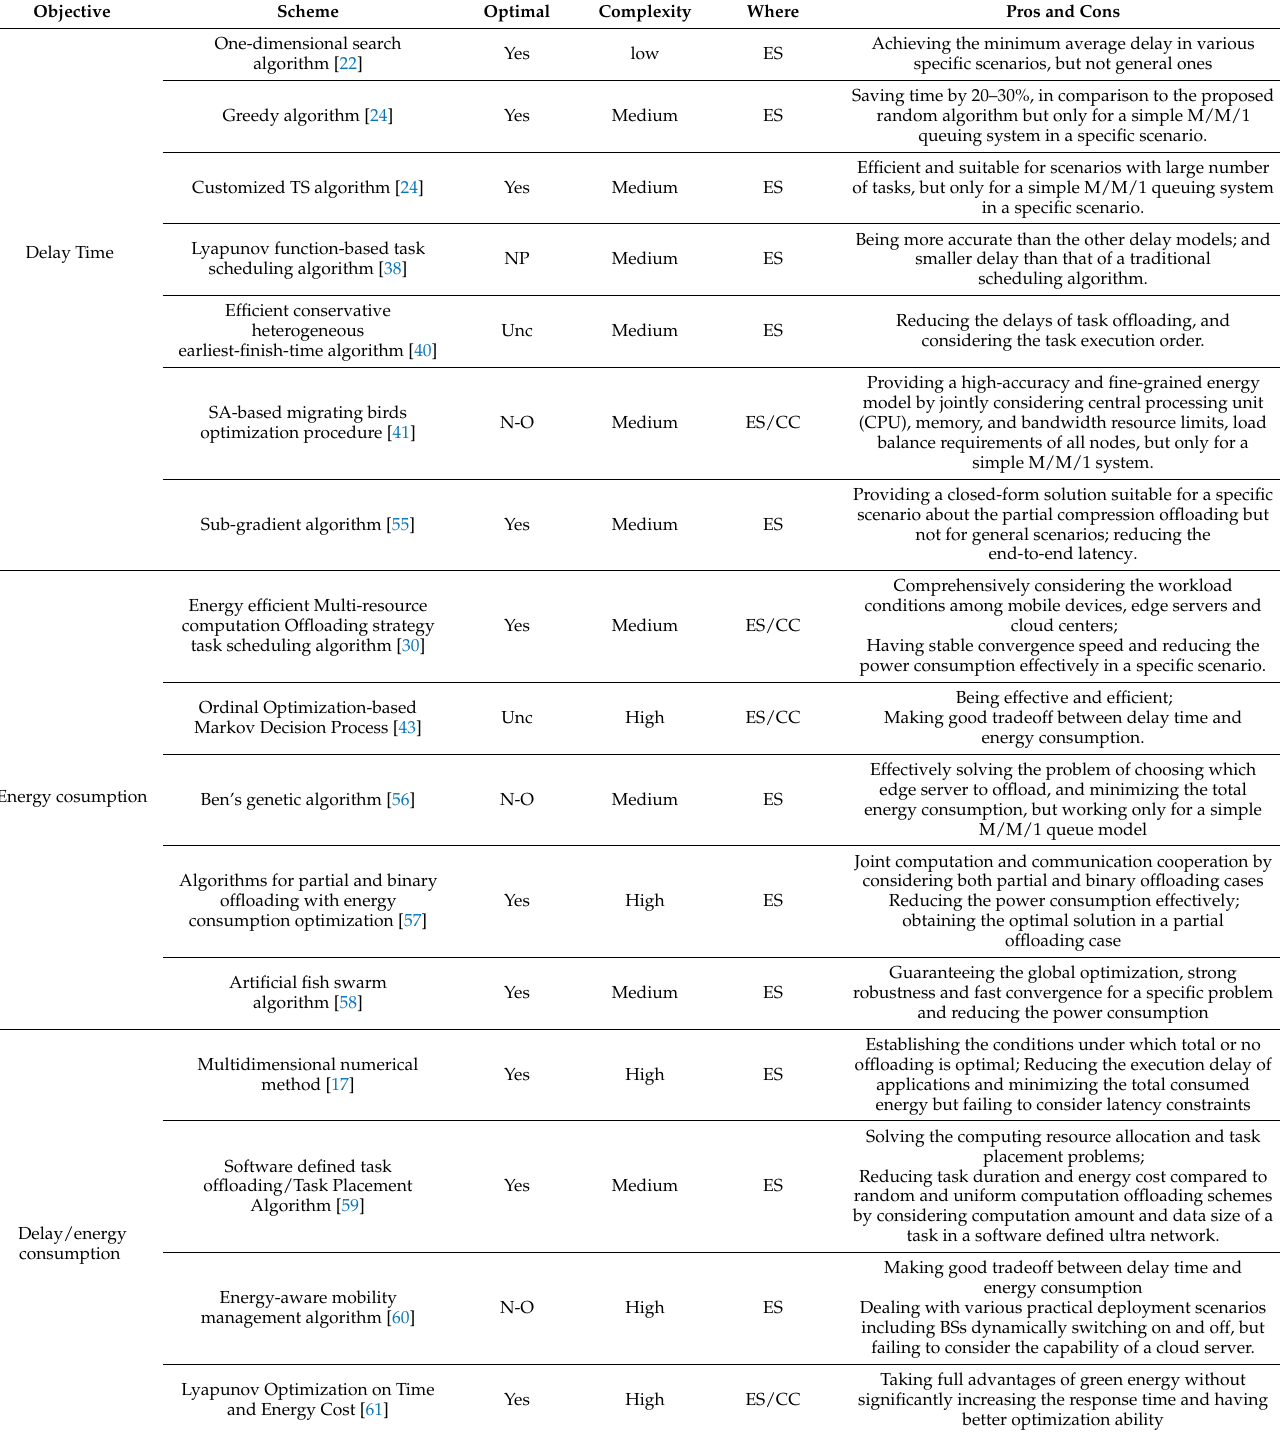
Table 2. Summary of algorithms for different optimization objectives (ES = edge server, CC = cloud center, Unc = uncertain and N-O =